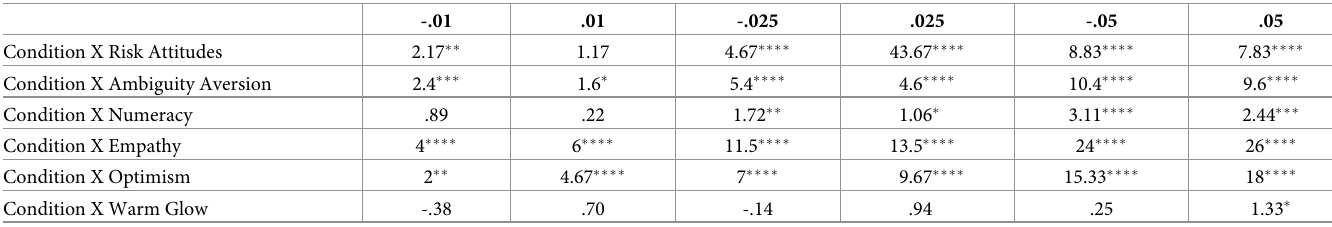
Table 6. TOST for final choice